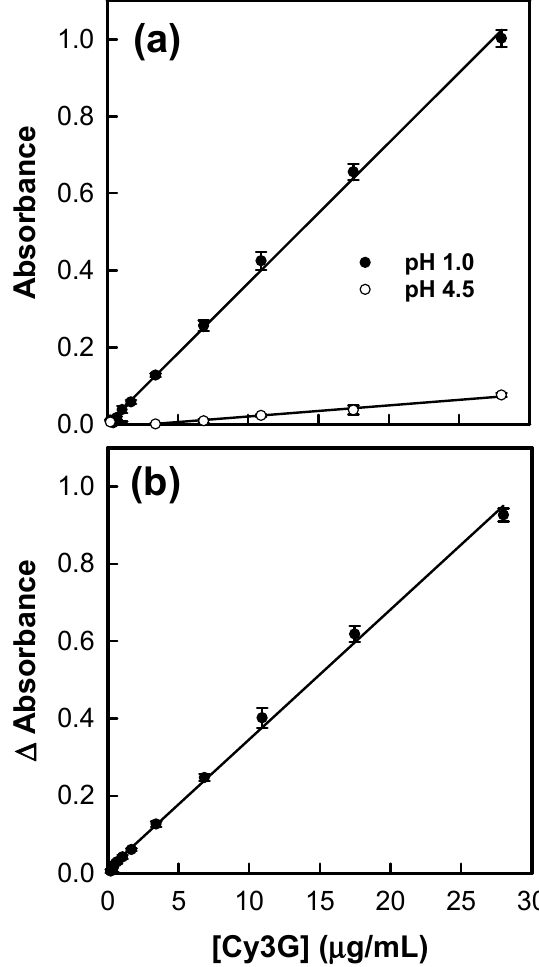
Figure 3. ( a ) Absorbance at different concentrations of Cy3G at pH 1.0 (solid circles) and pH 4.5 (open circles). ( b ) Dependence of the absorbance difference ( ∆ A = A (pH 1.0) − A (pH 4.5) ) as a function of the Cy3G concentration. The solid line shows the best linear fit to the experimental data.